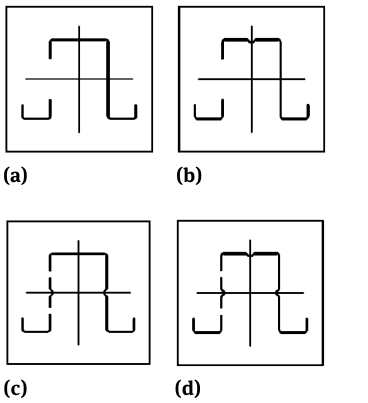
Figure 9: View of effective cross-section area of analysed hat pro- files – bending by the main axis z-z: a) profile without longitudinal stiffeners, b) profile with stiffener on upper chord, c) profile with stiffeners on webs, d) profile with stiffeners on upper chord and webs